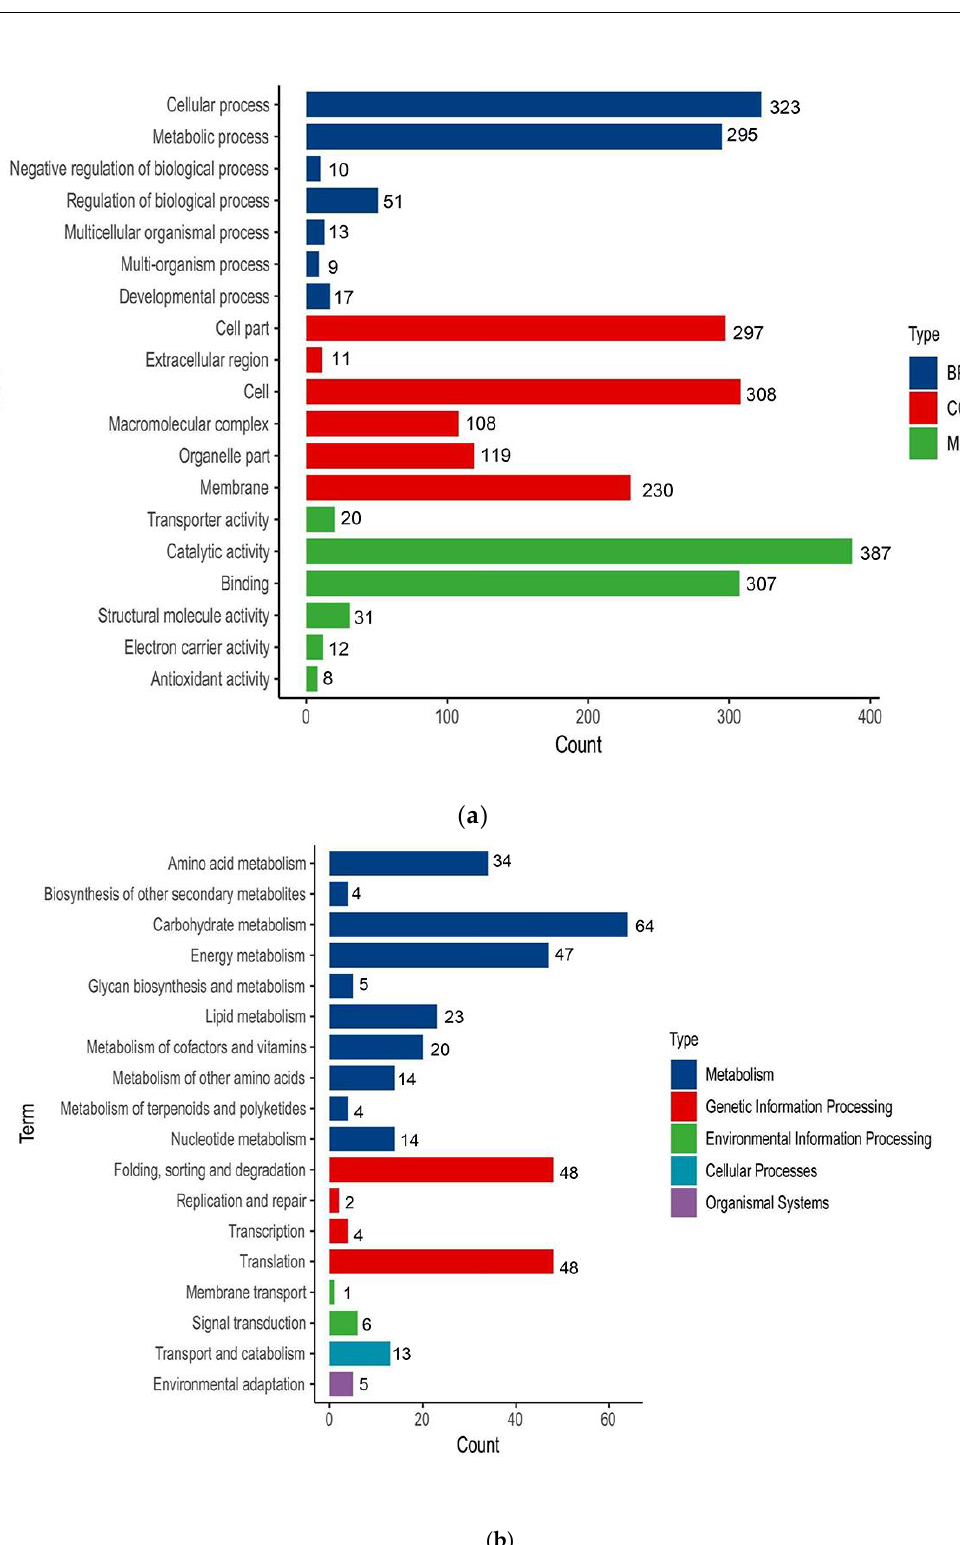
6 of 15 Figure 1 . label-free proteomic analysis: ( a ) First/Fifth harvest protein Venn of P. dentata . ( b ) Volcano plot of differentially abundant proteins (DAPs) from P. dentata (threshold = | log2 (fold change) |>1.2 or < 0.83 and p < 0.05). 3.2. GO and KEGG Pathway Annotation Analysis of the DAPs The GO classification of the ADPs between the first and fifth harvest P. dentata groups is shown in Figure 2a. The annotations of the DAPs in biological processes were signifi- cantly increased and focused on cellular processes (GO: 0009987, 323), metabolic processes (GO: 0008152, 295), and regulation of biological processes (GO: 00050789, 51). In cell com- position, cell (GO: 0005623, 308) and cell part (GO: 00044464, 297) were enriched. There were no significant differences in the cell membrane, membrane transport, or organelle expression. Under molecular functions, catalytic activity (GO: 00003824, 387), binding (GO: 0005488, 307), and other subsidiary proteins were enriched. The activation energy of the proteome continuously regulated P. dentata growth and development with the exten- sion of the harvest period. The KEGG pathway annotation showed that metabolic proteins occupied the highest proportion, followed by genetic information processing and envi- ronmental information processing (Figure 2b). Under metabolic proteins, amino acid me- tabolism (34), carbohydrate metabolism (64), and energy metabolism (47) were enriched. These were presumed to be related to photosynthesis and respiration during P. dentata growth and development. The carbohydrates were converted into nucleic acids, proteins, lipids, and structural polysaccharides and contributed to the differences in algal quality